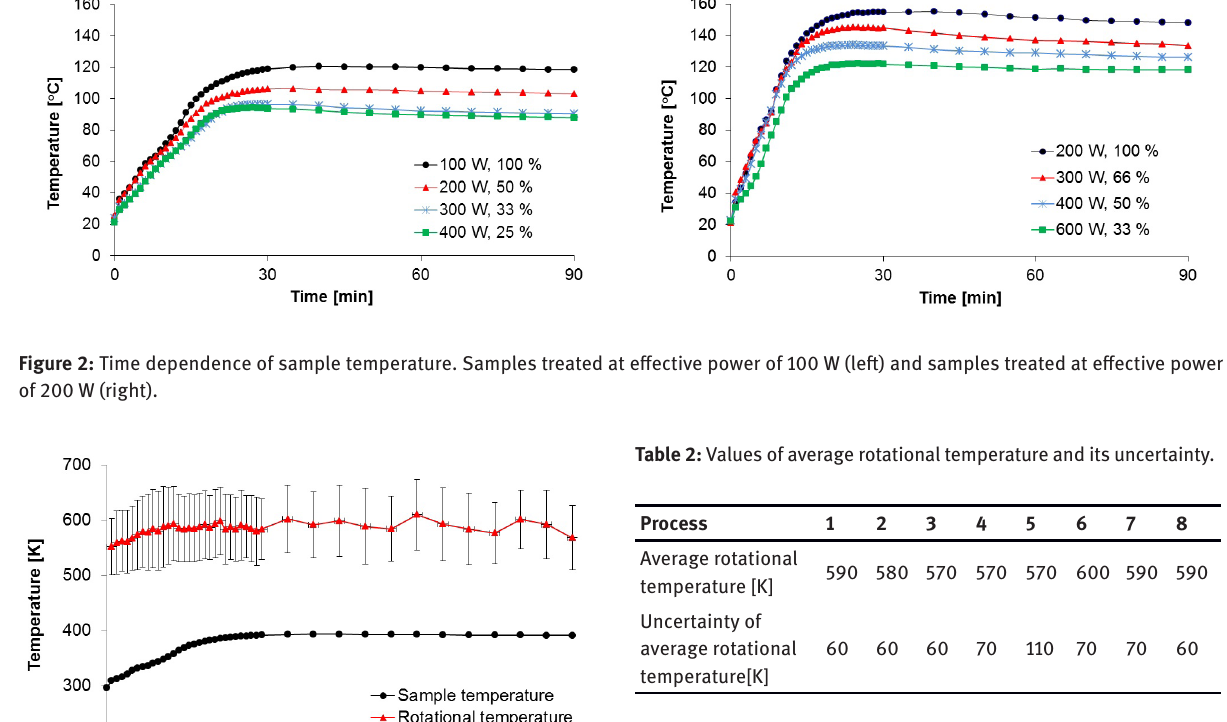
Table 3: The results of EDX analysis from the sample area (3.45×4.45 μm 2 ) after the plasma chemical reduction. All values are in mass